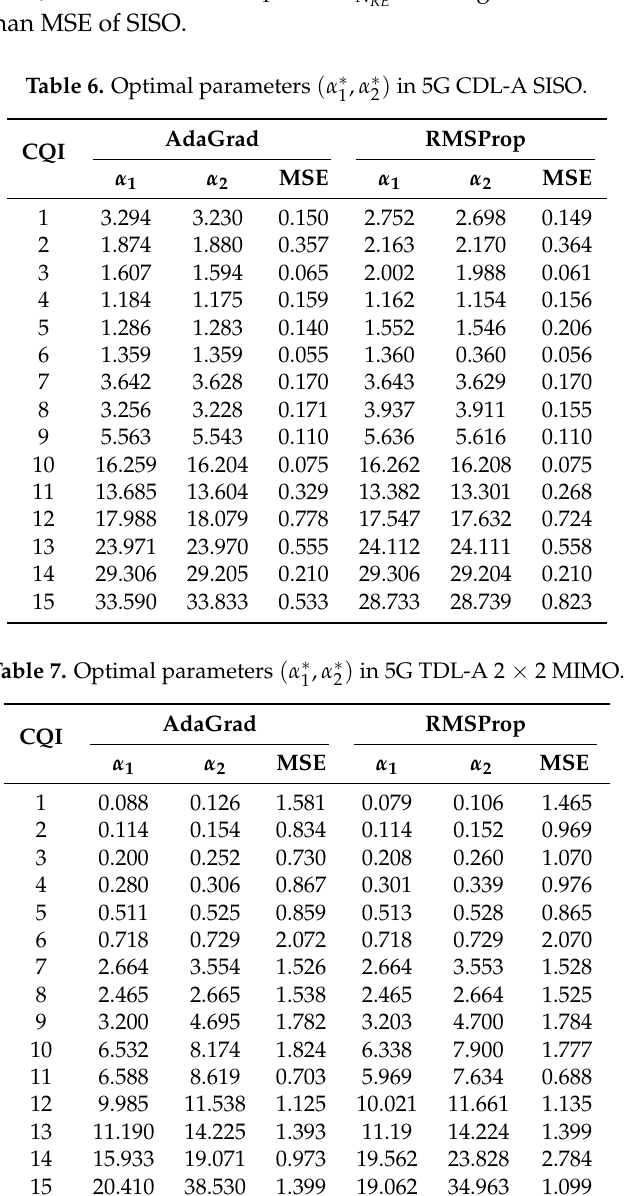
Table 6. Optimal parameters ( α ∗